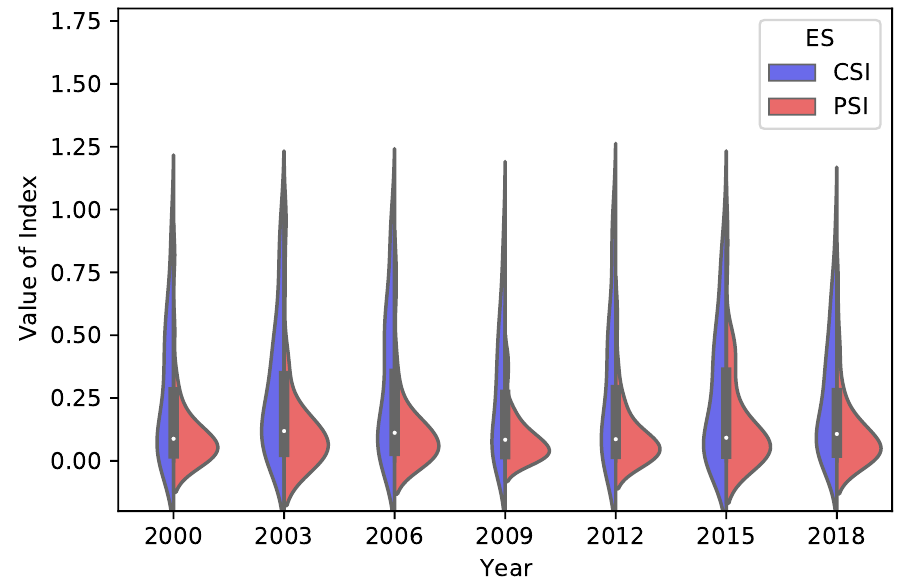
Figure 12. Distributions of country PSI and CSI based on the aggregate fossil energy